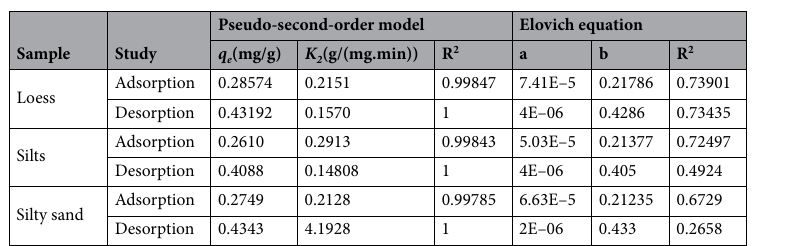
Table 3. Constants and coeffients of determination of Pseudo-second-order kinetics and Elovich models of sorption.